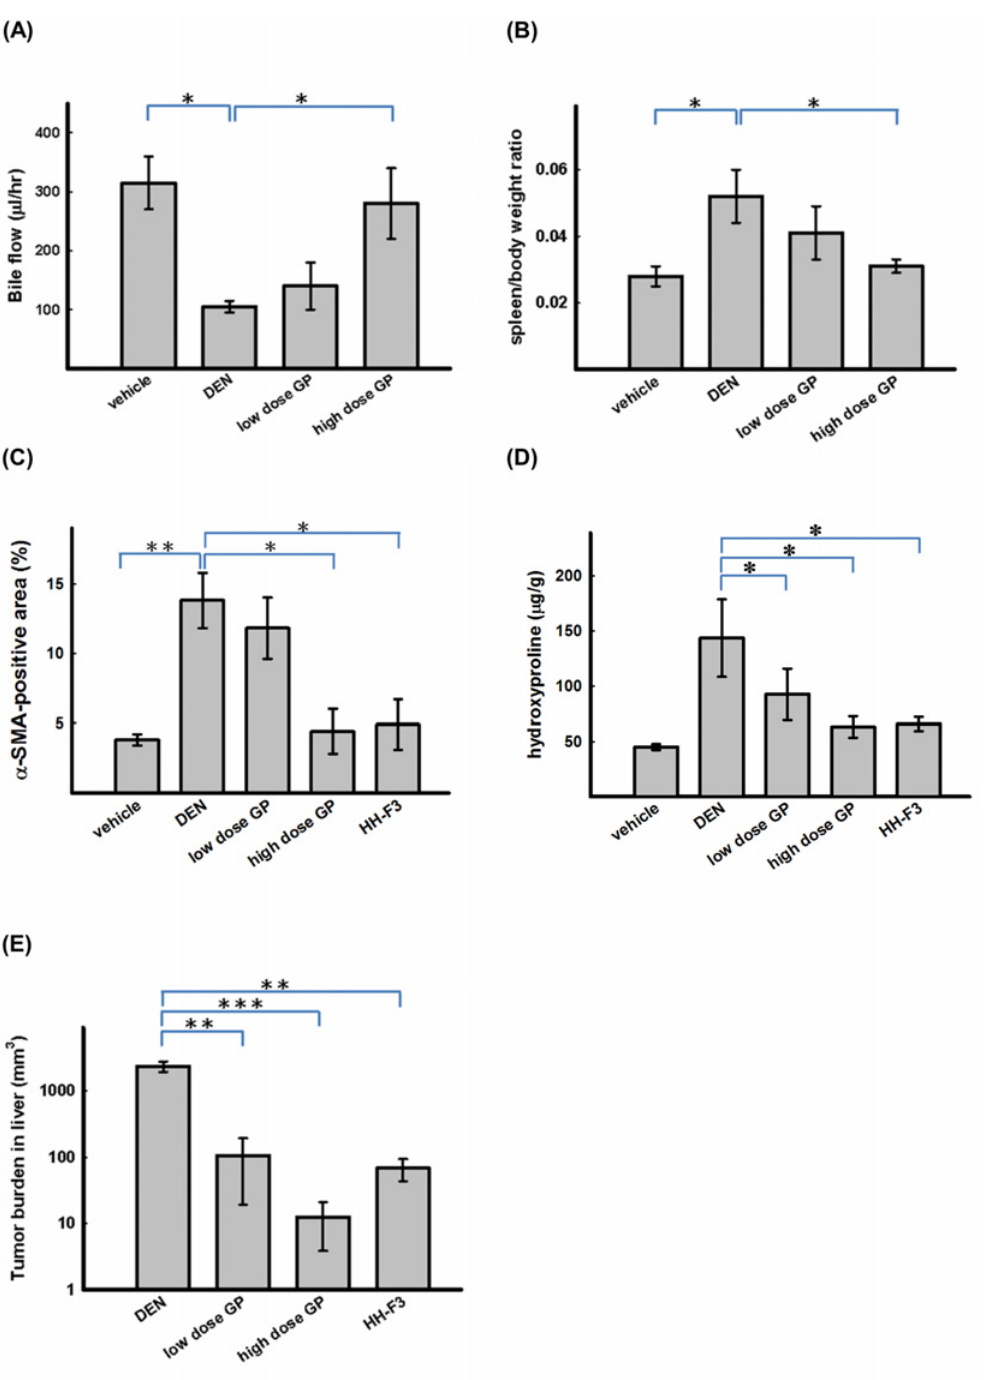
Fig 7. GP extracts and HH-F3 alleviate DEN-induced liver fibrosis and cancer in rats. The animals were divided into four groups and provided with tap water only (normal group) or with DEN-containing water (liver disease group). (A) Decreased bile flow in cirrhotic animals. The bile flow rate was recorded to measure liver function. * P < 0.05; ANOVA. (B) The spleen weight-to-body weight (BW) ratio of the animals in the high-dose GP treatment group was significantly lower than that of the animals in the DEN group (P < 0.05, ANOVA). (C) Treatment with GP extracts and HH-F3 significantly decreased liver hydroxyproline levels. (D) The percentages of α -SMA (+) areas were determined with a digital camera system using the 10 fields with the densest staining. * P < 0.05; ** P < 0.005, ANOVA. (E) Tumor burdens were expressed as the sum of the volume of all tumor nodules. ** P < 0.005, *** P < 0.001 relative to the DEN